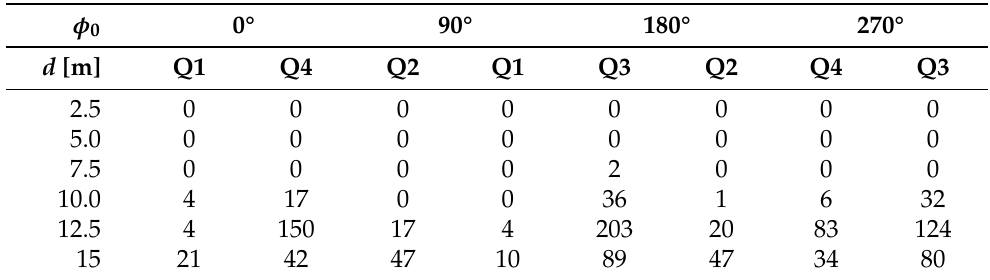
Table A1. Contributions to the number of freezes for each quadrant per experiment, described by initial azimuthal angle φ 0 and distance d .